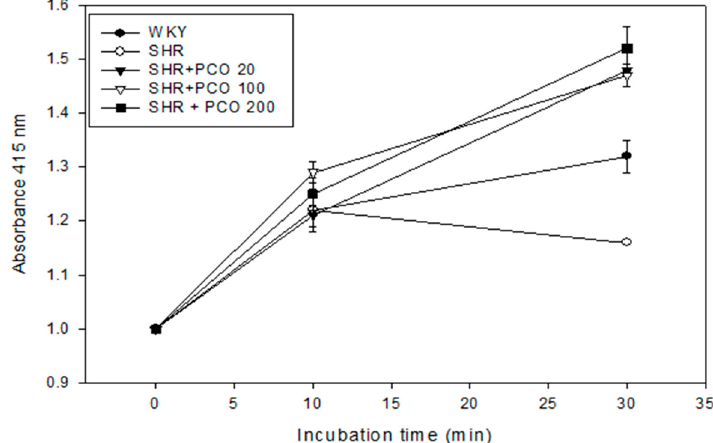
Figure 5. Changes of the paraoxonase activity in HDL after eight weeks of policosanol consumption in different groups.